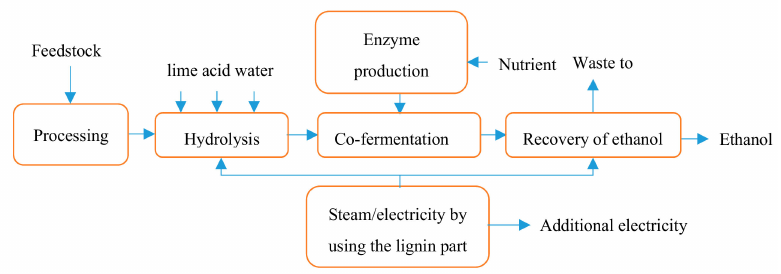
Figure 2. Schematic diagram of straw based ethanol production.